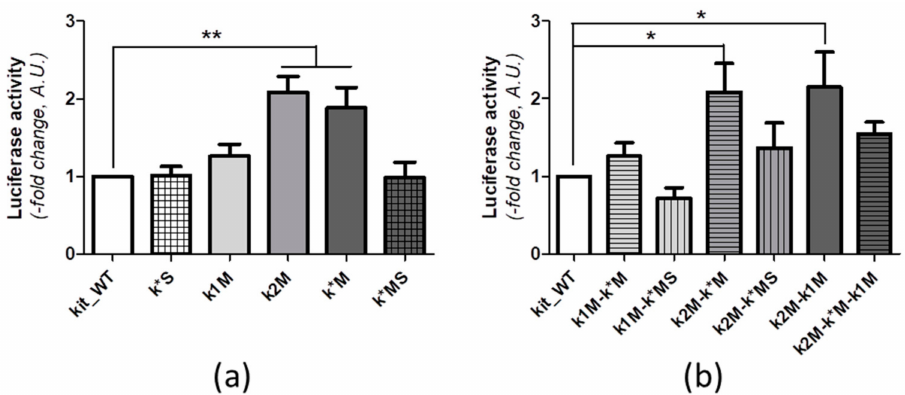
Figure 5. Luciferase activity in MCF-7 cells transiently transfected with plasmids containing kit_WT and mutated sequences at a single ( a ) or multiple ( b ) G-quadruplex (G4) forming sites. The firefly signal was normalized to renilla signal. The -fold change of the luciferase activity between WT and each mutated sequence was calculated in terms of arbitrary units. Five independent experiments were performed and each experimental condition was tested in sextuplicate. Data are expressed as means ± SEM. Statistical analysis: One way ANOVA followed by Dunnett’s multi comparison test (* p < 0.05; ** p <